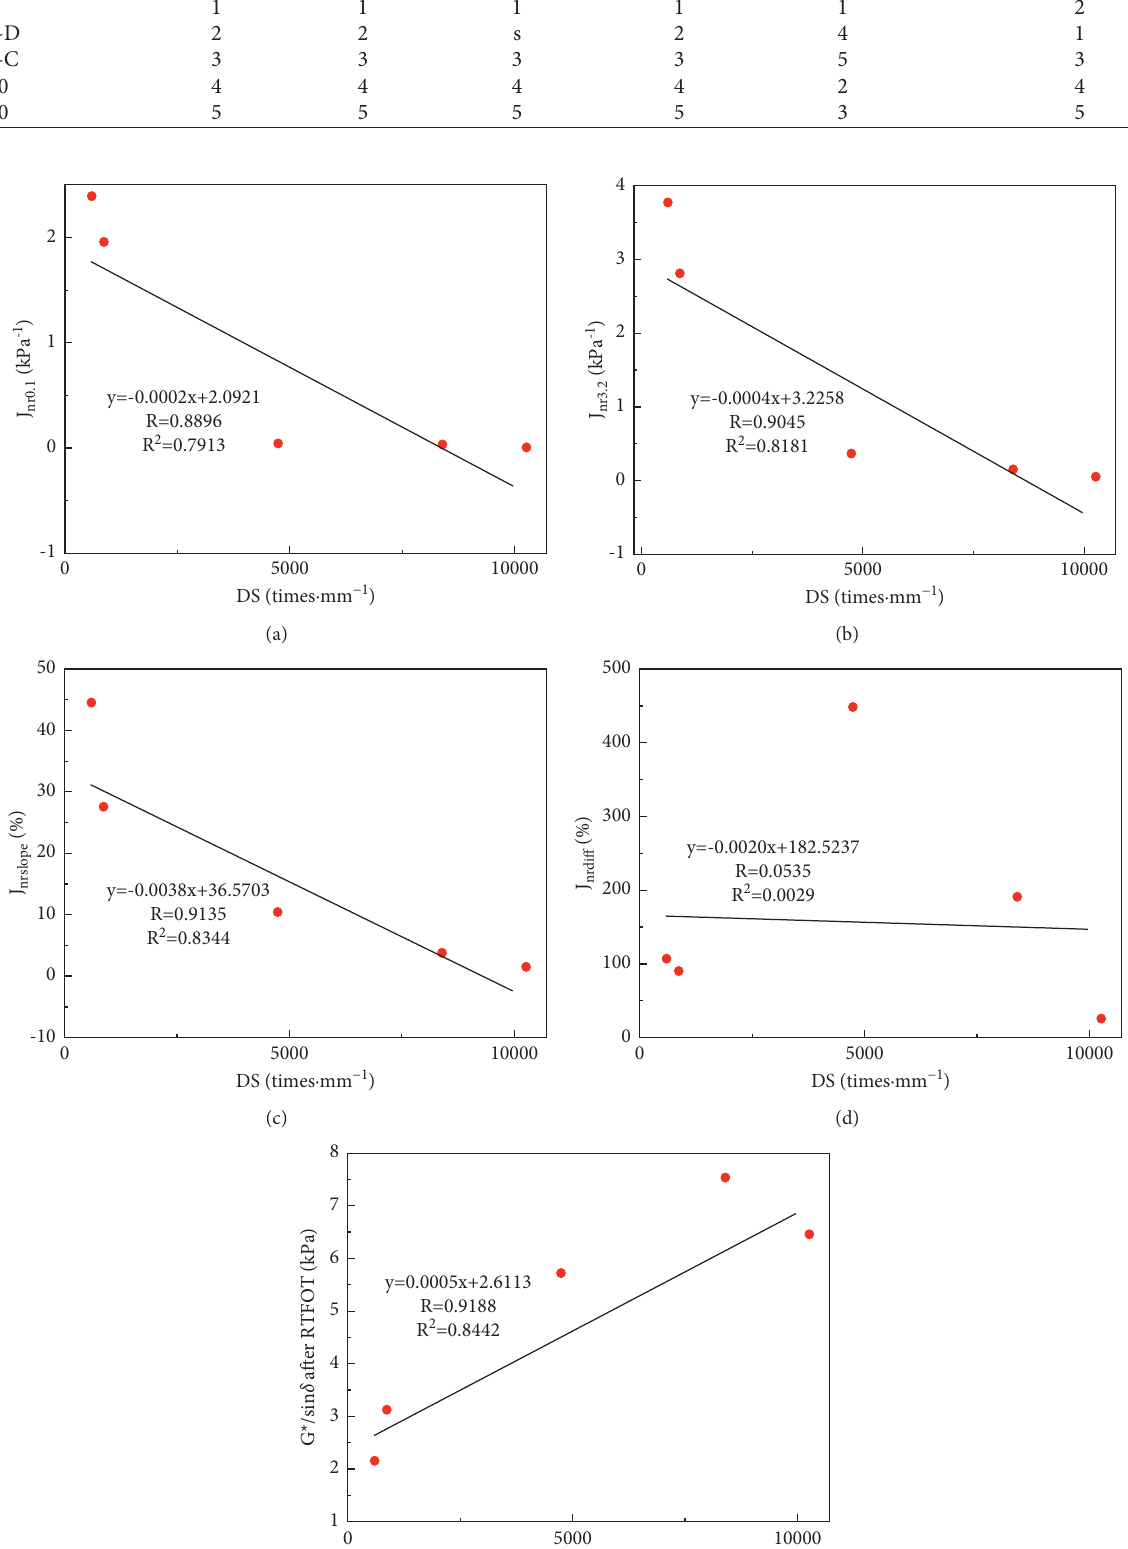
G ∗ /sin δ after RTFOT at 64 ° C.